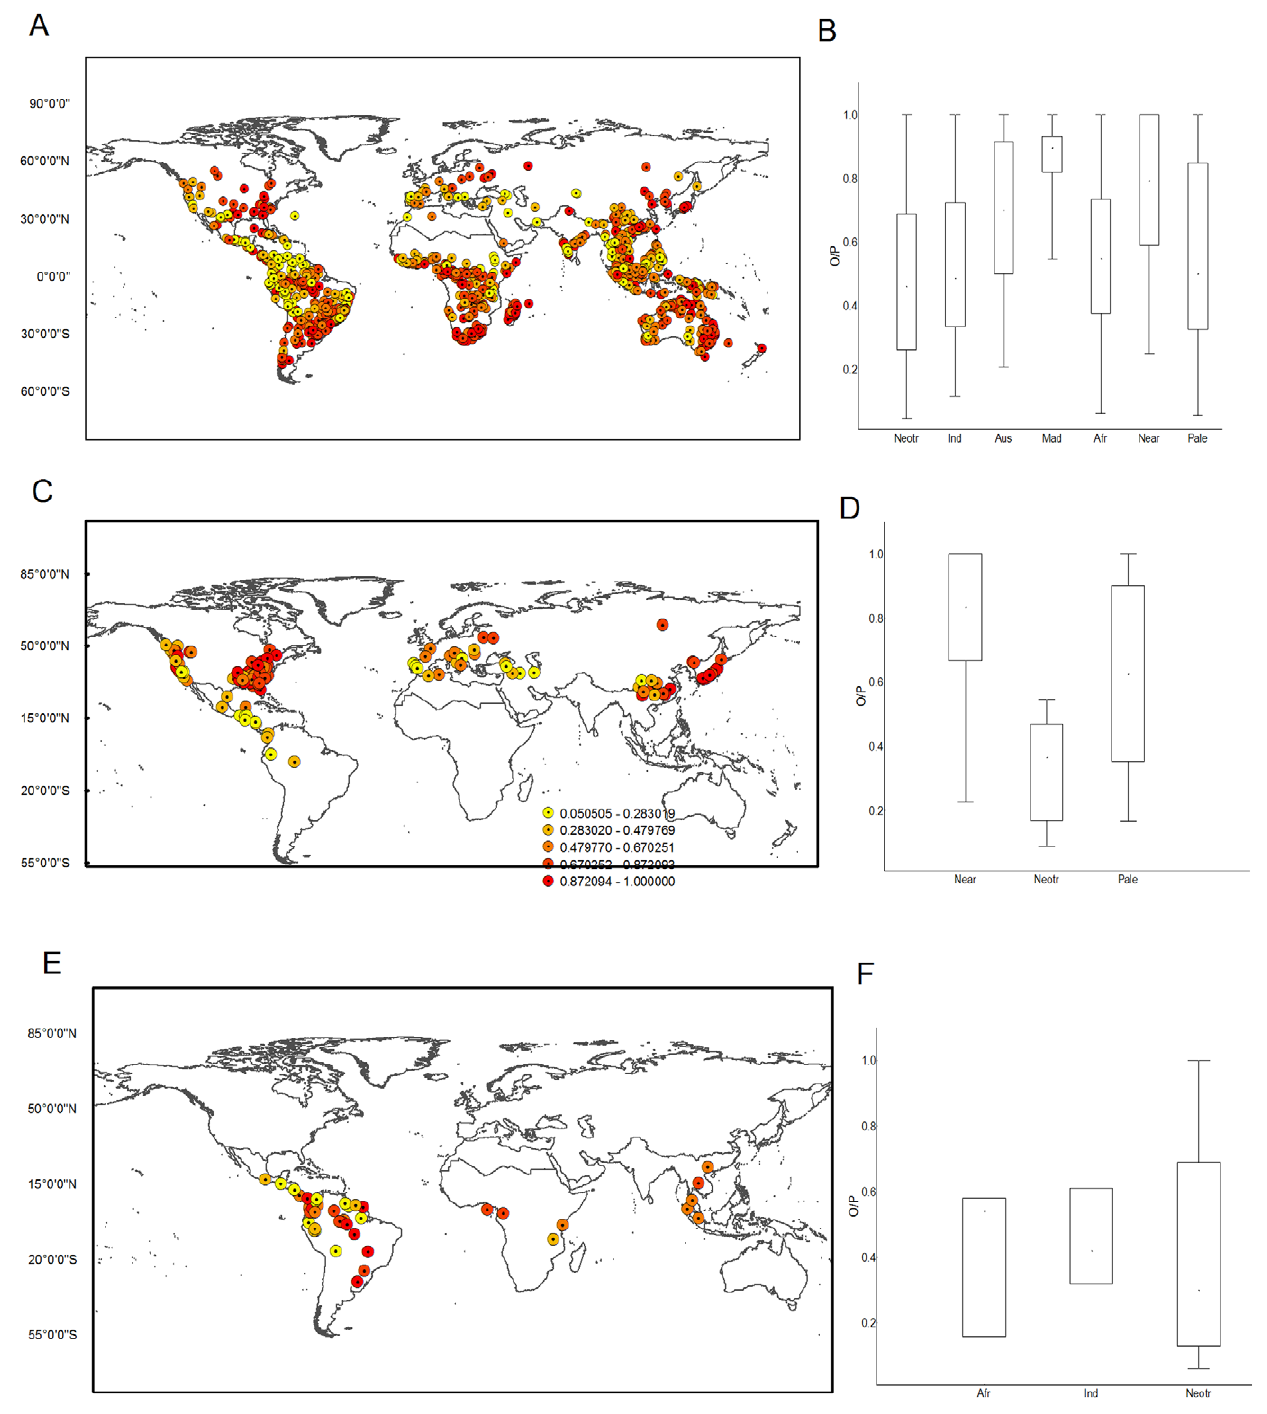
Figure 4. Distribution of the centroids of species geographical distributions and their respective level of equilibrium ( O = P ): (A) Anura, (C) Caudata, and (E) Gymnophiona. Differences among regions in each order (B) Anura (N=1655) (D) Caudata (N=129) (F) Gymnphiona (N=33).